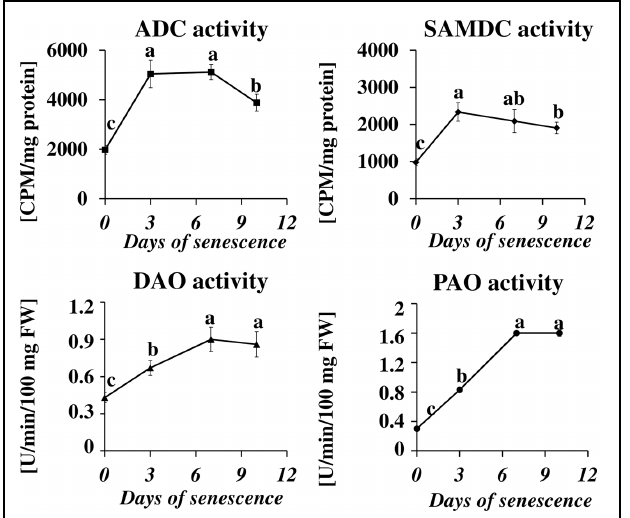
FIGURE 3 | The time course of ADC, SAMDC, DAO, and PAO activities in barley leaves undergoing dark-induced senescence. ADC, arginine decarboxylase, SAMDC, S -adenosyl-methionine decarboxylase; DAO, diamine oxidase; PAO, polyamine oxidase. Enzyme activities were determined as described in Section “Materials and Methods.” The values for ADC and SAMDC activity were reported in CPM relative to protein in mg. DAO and PAO activity are reported in U relative to time (min) and leaf fresh weight (FW). The differences in the measured parameters were analyzed for statistical significance using one-way ANOVA and the Tukey–Kramer Multiple Comparison Test ( n = 6, p < 0.01). The same letters on bars describe non-significant differences between